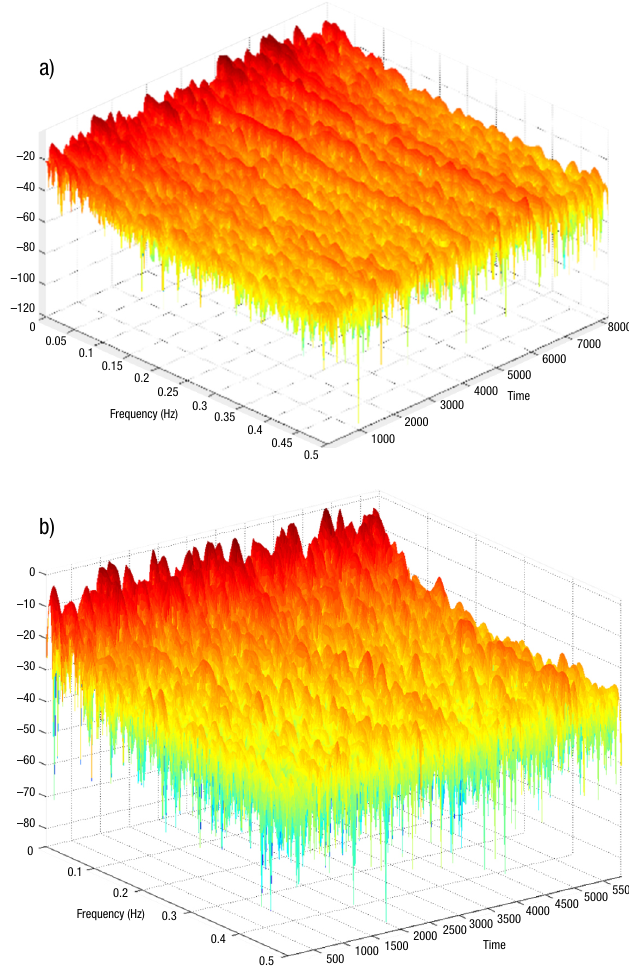
Fig. 11. Bund 1 min – time period spectrogram (a), 5 min – time period spectrogram